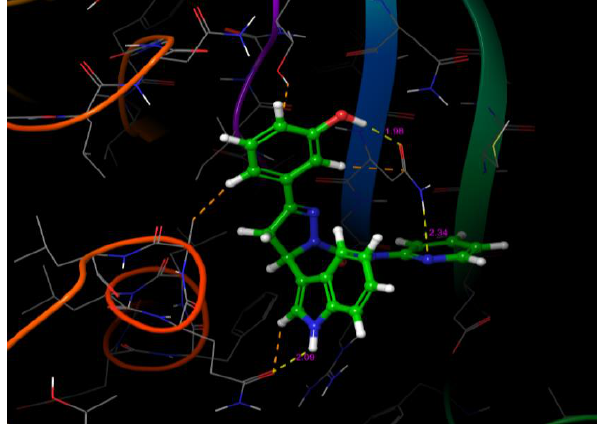
Figure 3. Docked molecules poses in the binding site of the AhR – ARNT complex.